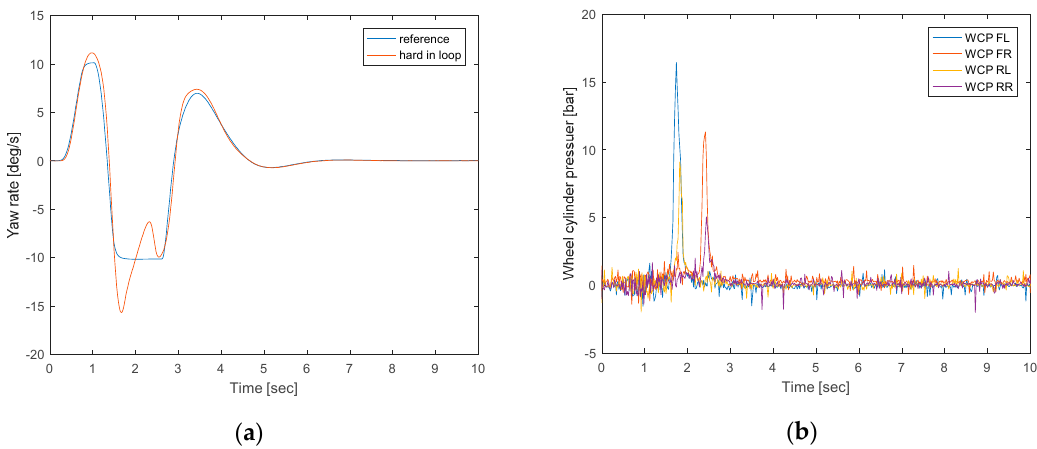
Figure 14. Test results based on the conventional PID-based controller at 𝑢 = 80 km/h and 𝜇 = 0.5. ( a ) is a comparison of the nominal and actual values of the yaw rate, and ( b ) is the wheel cylinder pressure value collected from the wheel cylinder pressure sensor.